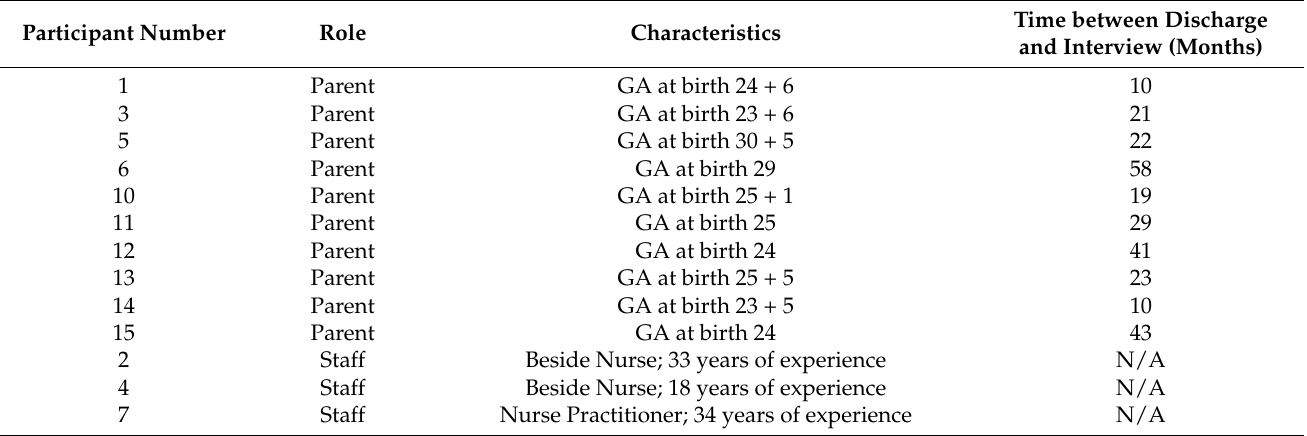
Table 1. Interviewee